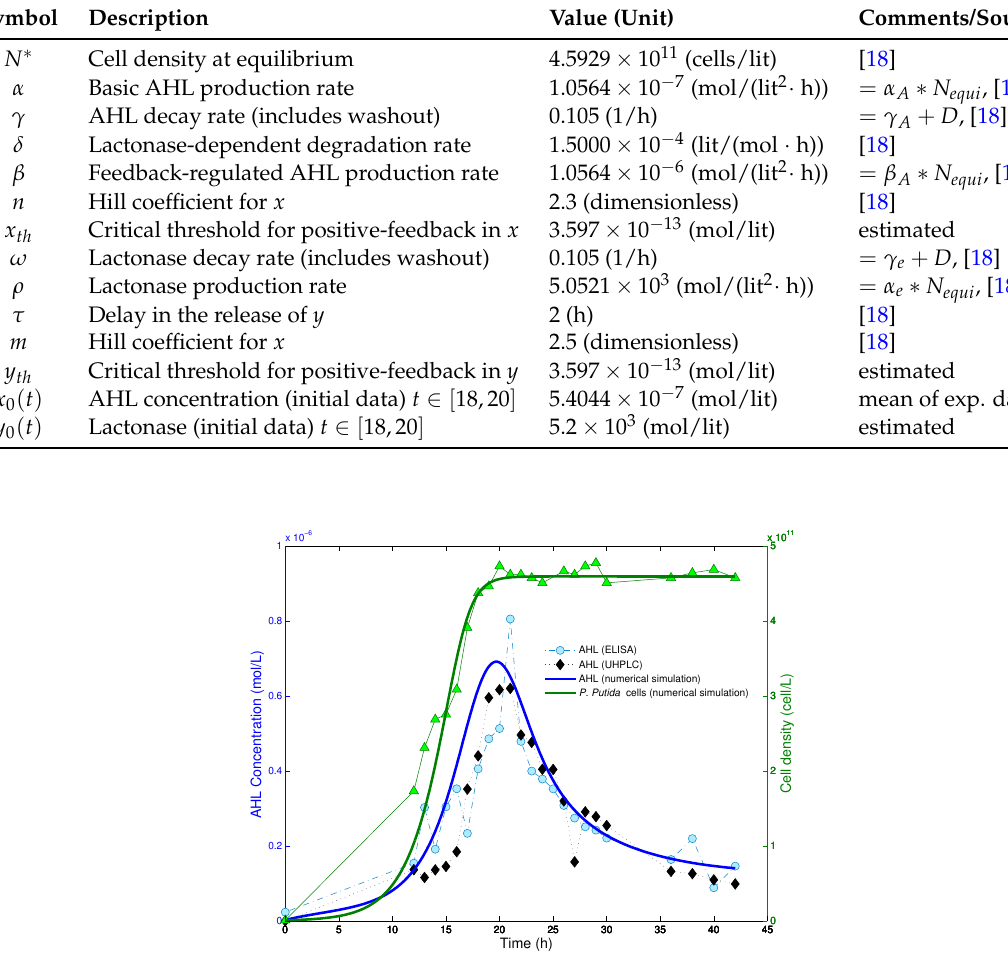
Figure 2. Experimental data and numerical solution of the mathematical model (4). Picture adapted from [18]. Copyright 2014, Springer-Verlag Berlin Heidelberg. The cell population reaches its equilibrium after approximatively 20 h from the beginning of the